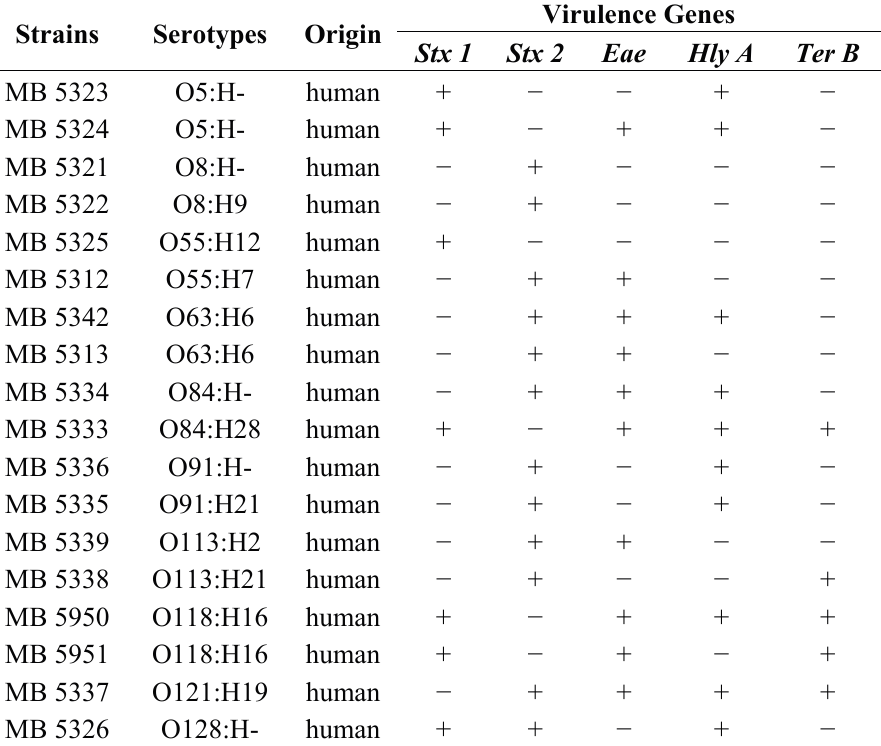
Table 1. Overview of STEC, EPEC and commensal E. coli